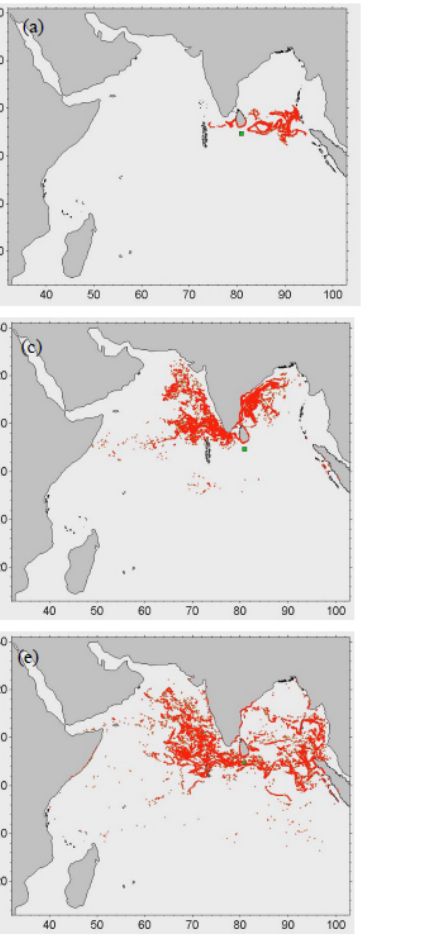
Figure 5. Results of a particle tracking simulation using Ichthyop in the northern IO. In total, 10000 passive particles were released on 1 September to the south of Sri Lanka (green square) and tracked using hourly surface current output from the HYCOM model to illustrate the influence of the northern IO surface dynamics on the transport of buoyant plastics. Note that the release location does not represent a location where plastics enter the ocean but instead was chosen as a central location that is influenced by the reversal of monsoonal